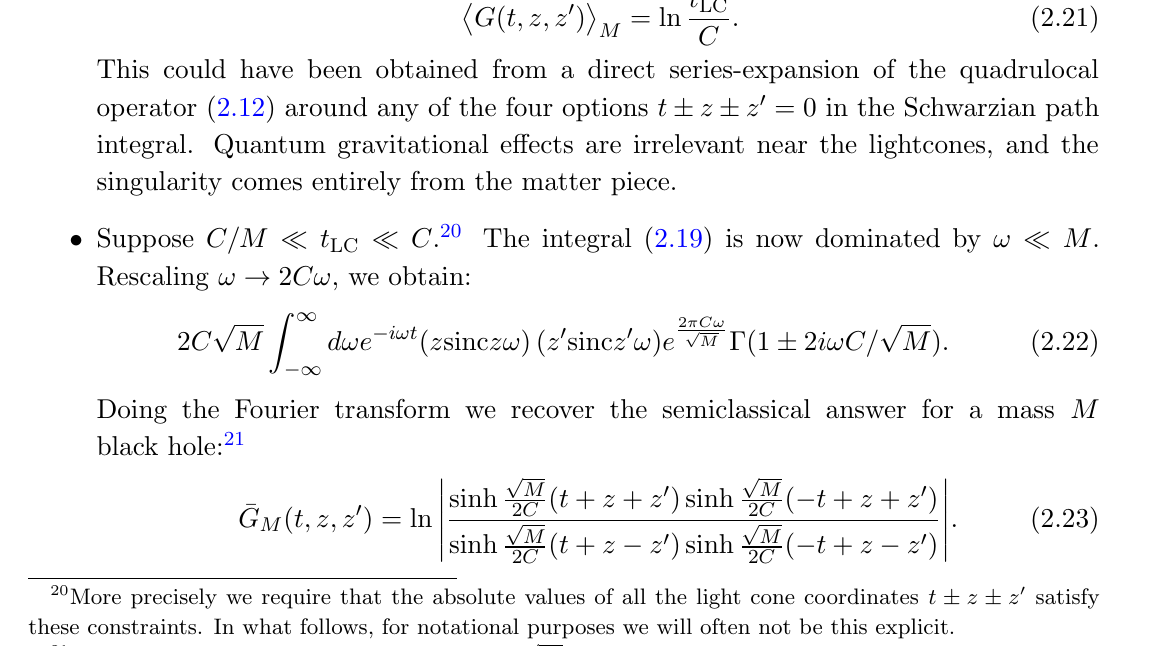
Figure 4 . Exact (full) and semi-classical (dashed) pure state bulk two-point functions and ¯ G ( t, z, z ) for different values of M ( C = 1 / 2). Evaluated at z G bb ( t, z, z (cid:31) ) (cid:31) M (cid:30) M (cid:31) vertical line) and for a range of z values. Blue: it = 0 . 1. Green: it = 0 . 5. Orange: it = 1. Red: it =